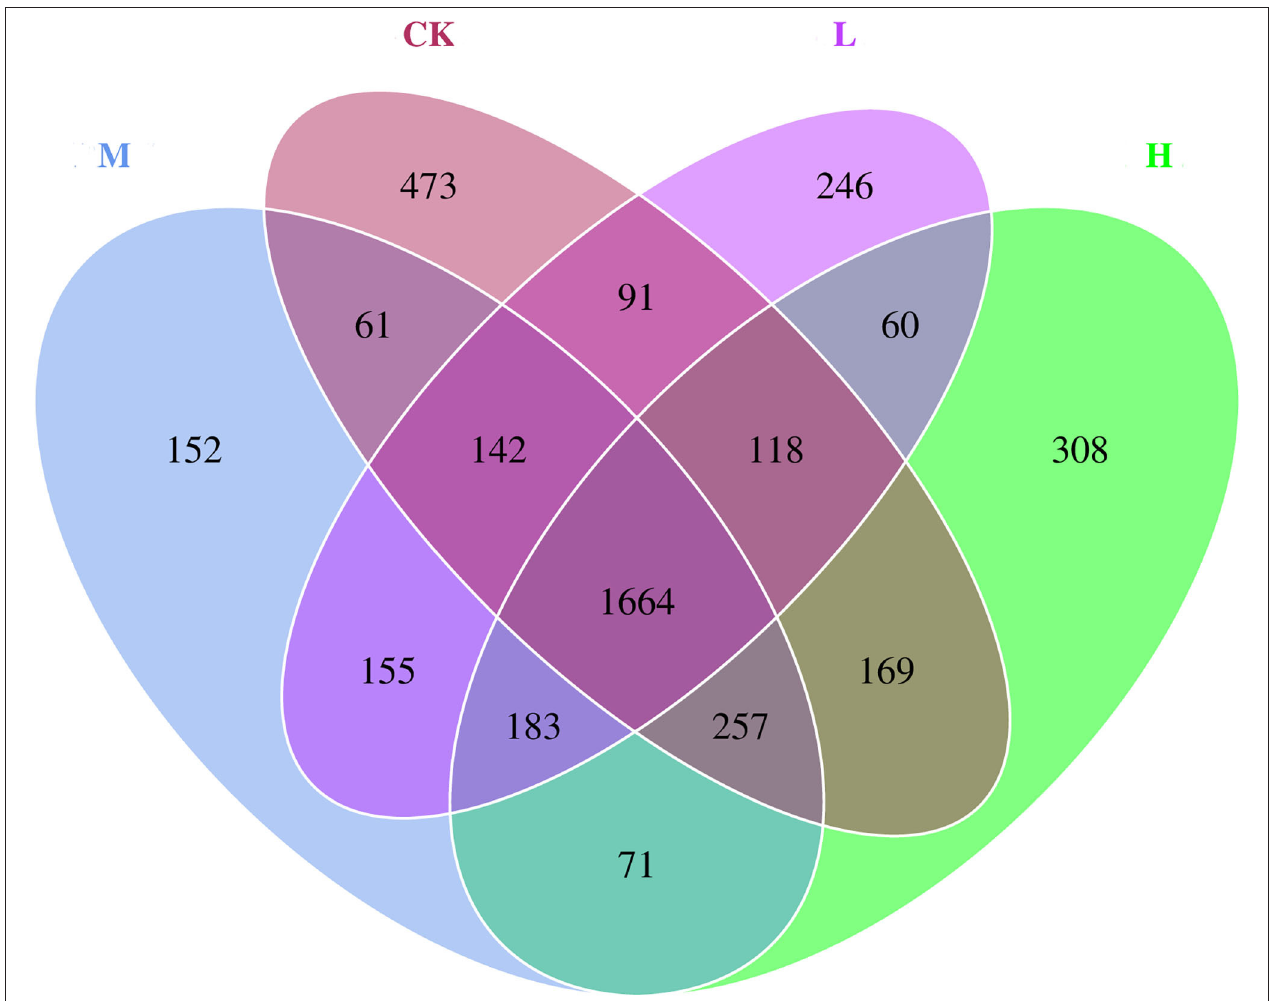
FIGURE 3 | Microbial diversity Venn diagram of rumen bacteria of Tibetan sheep at the four SeY doses (mg SeY/kg dry matter) (CK, 0; L, 0.09; M, 0.18; H, 0.36). CK, control; L, low Se, M, medium Se; H, high